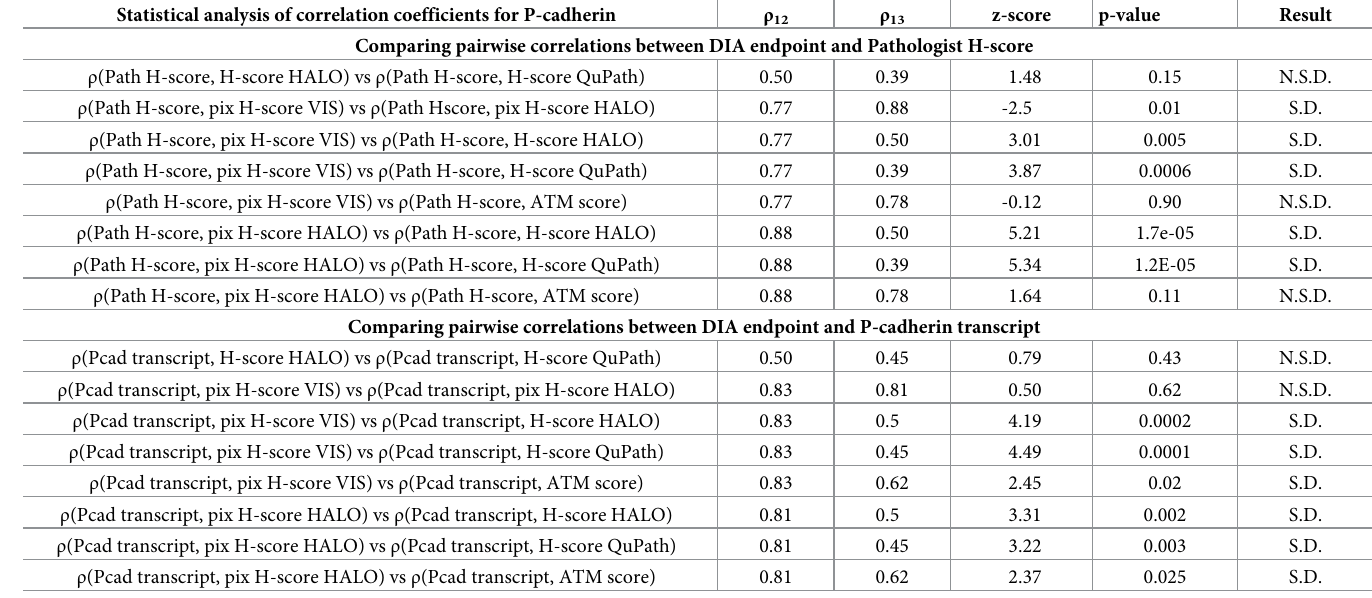
Table 1. Table lists the results of William’s t-test to test for significant difference in the Spearman correlation coefficients between P-cadherin transcript or patholo- gist H-score and different DIA endpoints. Statistical analysis of correlation coefficients for P-cadherin ρ 12 ρ 13 z-score p-value Result Comparing pairwise correlations between DIA endpoint and Pathologist H-score